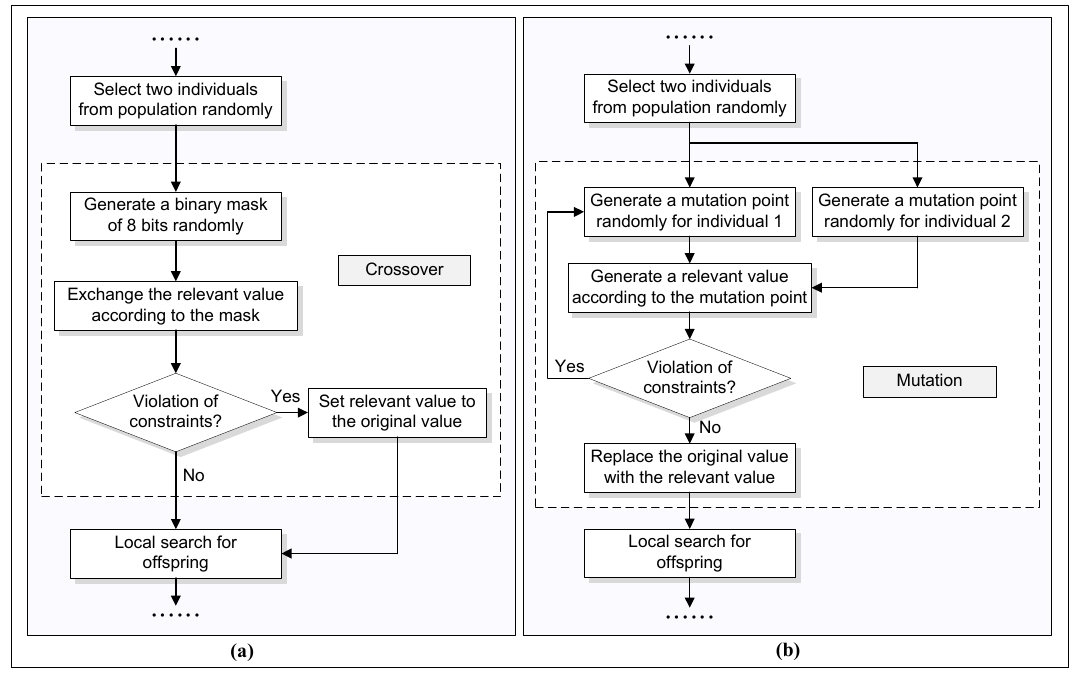
Figure 6. Flowchart for the ( a ) crossover process; and ( b ) mutation process.